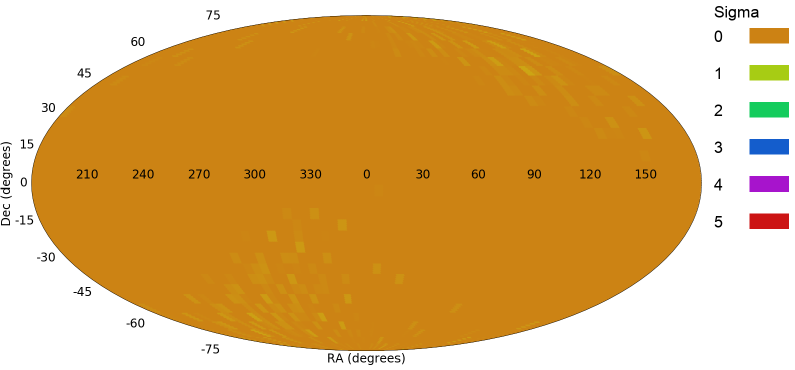
Figure 7. The statistical significance of a dipole axis in galaxy spin directions from different ( α , δ ) combination in DES when the galaxies are assigned random spin